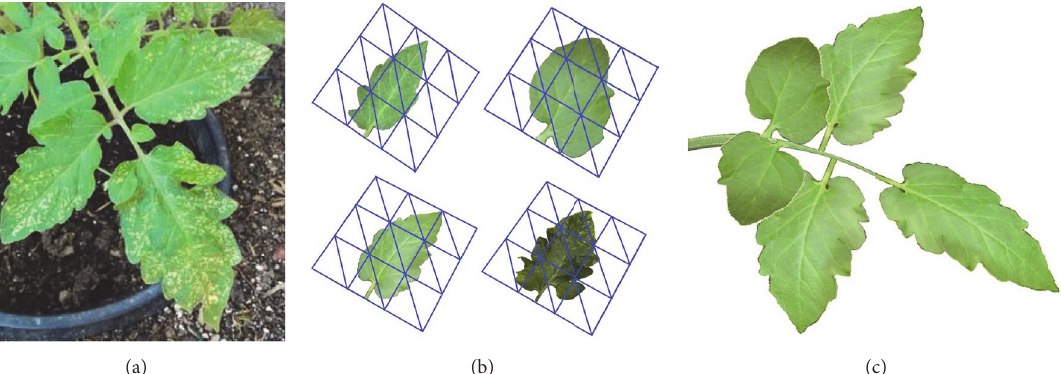
Figure 2: Modeling leaves with deformable meshes. (a) A tomato phyllotaxy photo. (b) Different leaf shapes in different growth stages. (c) Building a phyllotaxy with two different shape